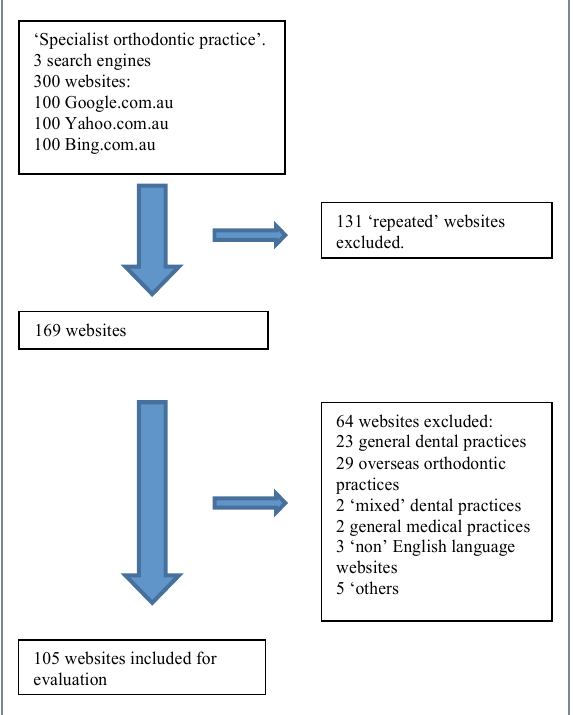
Figure 2. Flowchart showing website